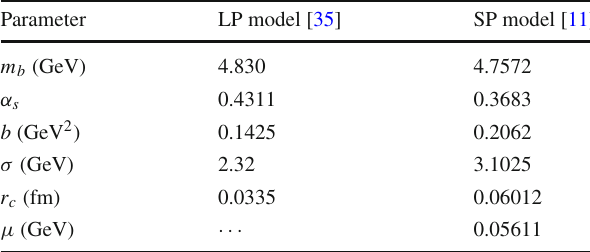
Table 1 Quark model parameters for the linear potential (LP) model and screened potential (SP) model adopted from Refs. [11,35] Parameter